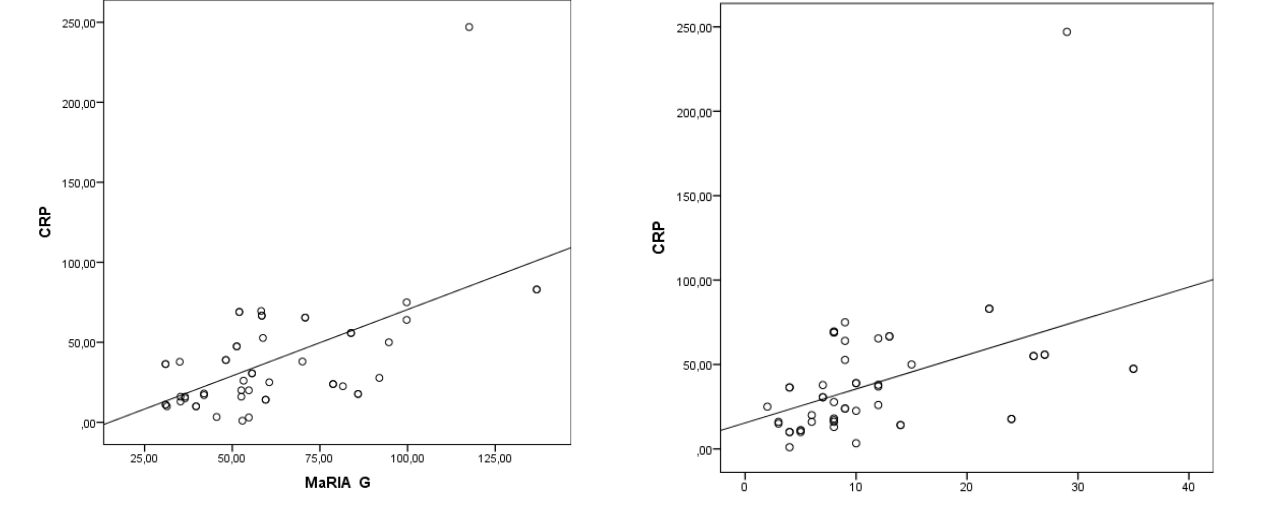
Figure 6A: Correlation between CRP and Magnetic Resonance Index of Activity Global.